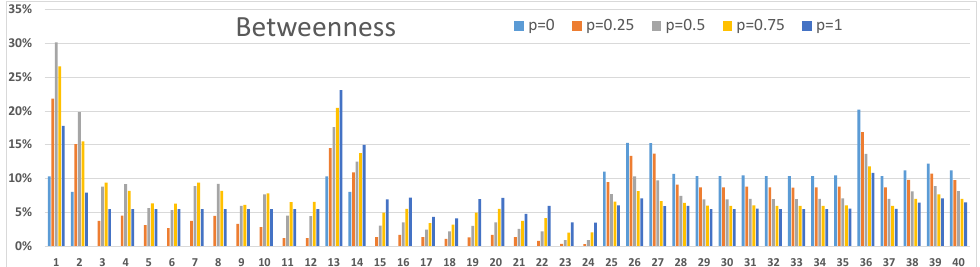
Figure 8. Betwenness values of nodes in the network structure of Fig. 1. Connections within networks function with resilience values p = 0,0.25,0.5,0.75 and 1. The results correspond to Figure